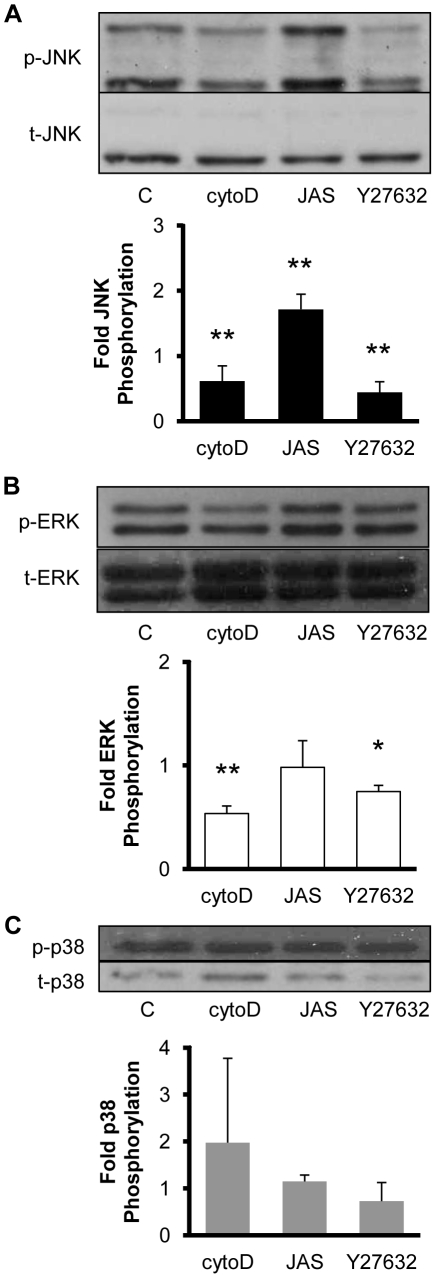
JNK and ERK phosphorylation is decreased by inhibitors of Rho kinase and actin polymerization.Representative Western blots are shown of phospho-specific and total JNK (A), ERK (B) and p38 (C) from cell lysates collected from confluent BAECs treated for 30 min with vehicle (0.1% DMSO; lane 1), 50 nM cytochalasin D, 10 nM jasplakinolide or 10 µM Y27632. Optical density measurements were quantified to determine relative amounts of phosphorylated MAPK normalized by the respective total MAPK. The values (means±S.D.; n = 4) indicate the fold change in phosphorylation relative to the DMSO-treated controls for each individual experiment. * and ** indicate significant difference from the control (* P<0.05, ** P<0.01).